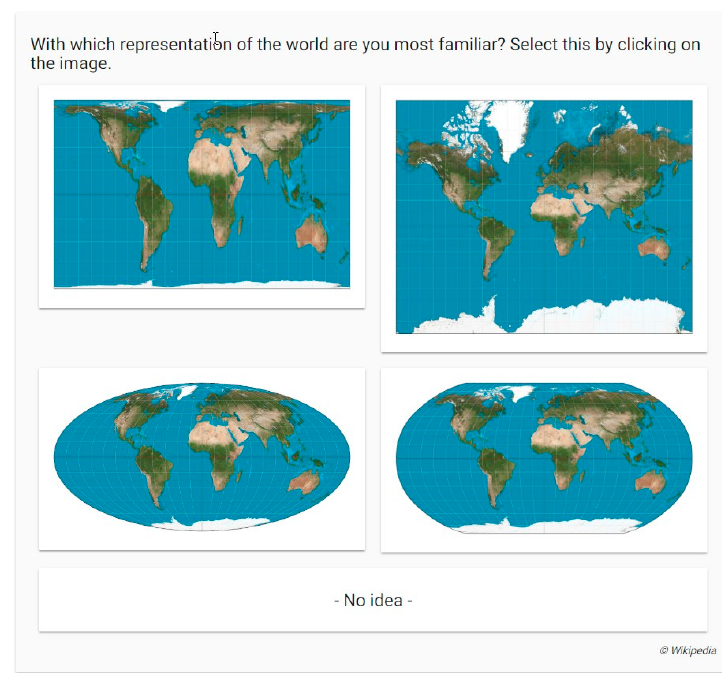
Figure 5. Question: ‘With which representation of the world are you most familiar?’ and five possible answers: Gall–Peters projection, Mercator projection, Mollweide projection, Robinson projection, or ‘No idea’.